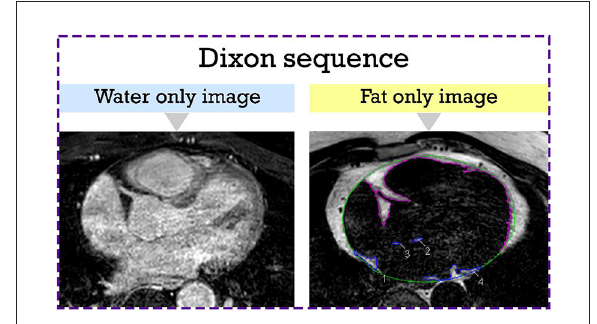
FIGURE1 Epicardial adipose tissue segmentation from the axial Dixon MRI sequence. Hyperintense regions around the LA which represent LA EAT are manually contoured in blue. The rest of the EAT is contoured in purple. The pericardium is outlined in green. EAT, epicardial adipose tissue; LA, left